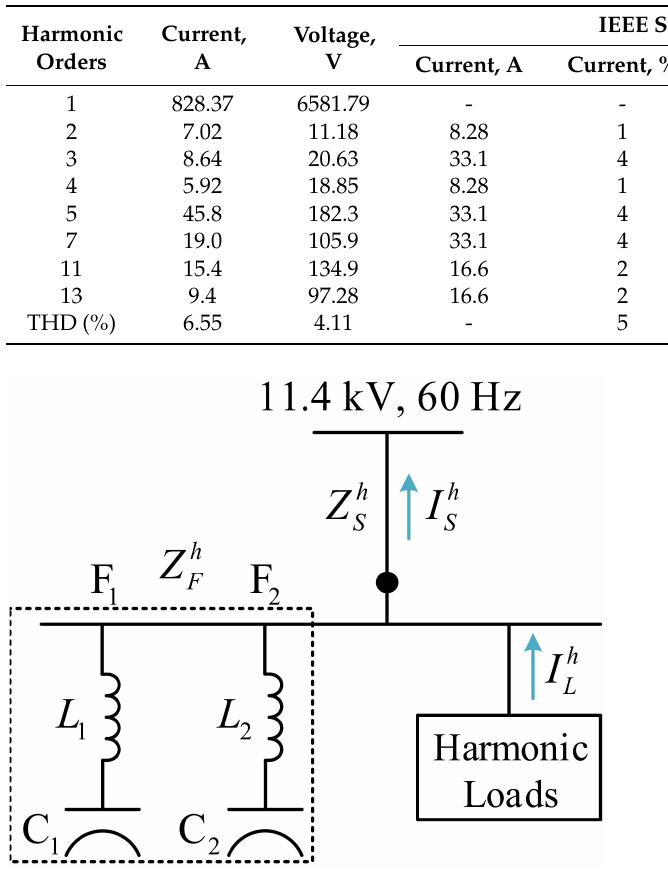
Table 4. Distributions of harmonic current and voltage without PPFs.